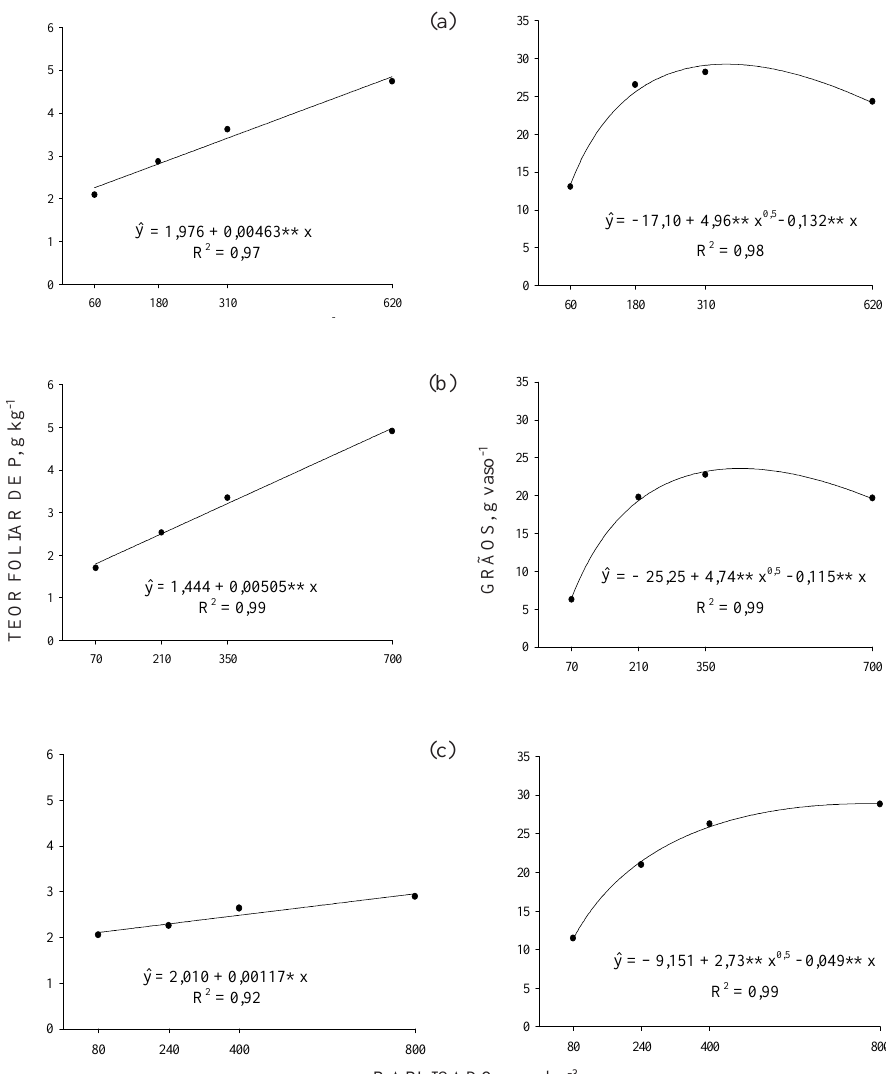
Figura 1. Teores foliares de P no florescimento da soja e produção de grãos de acordo com as doses das FT1 e FT2 nos solos NQ (a), LVAm (b) e LVAr